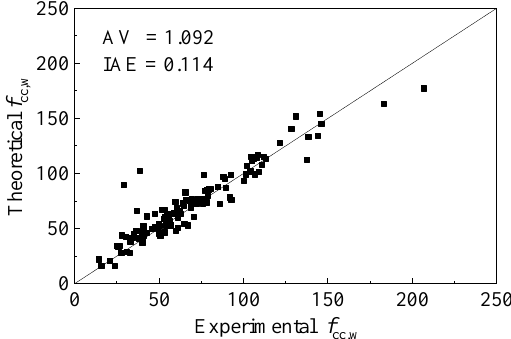
Figure 2. Performance of the peak stress model.